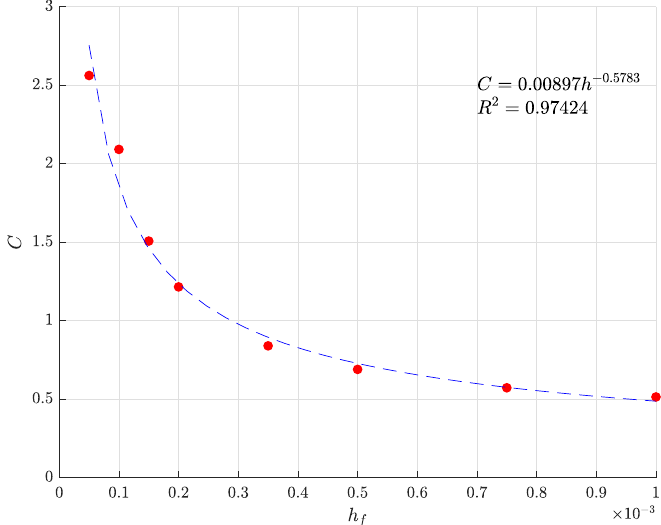
Figure 22. C correlation as a function of h f